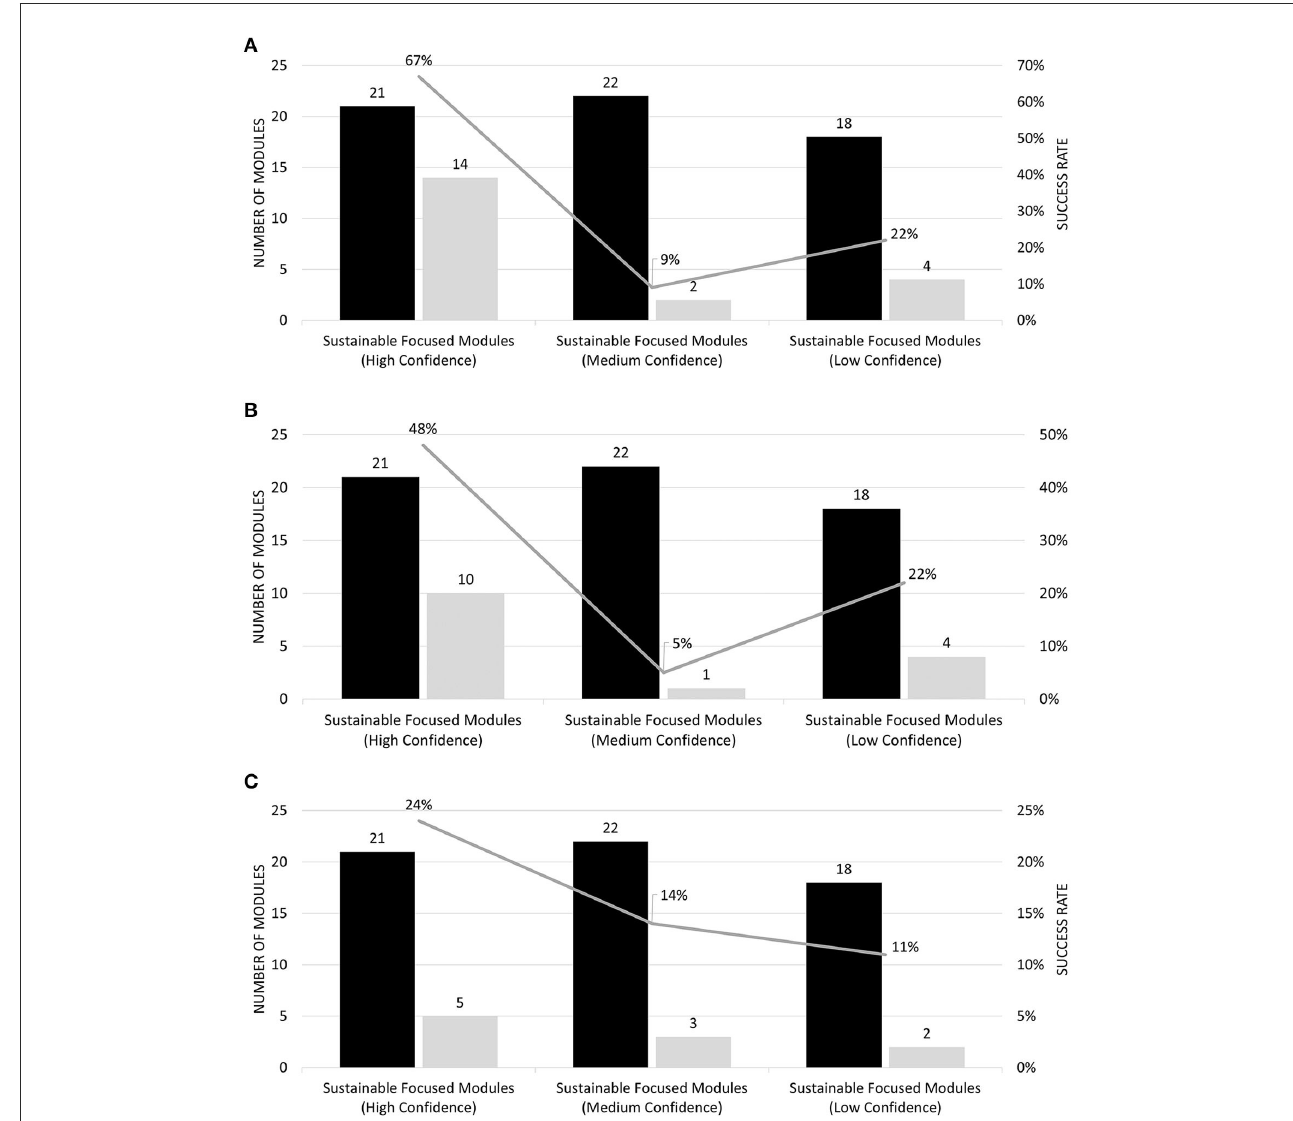
FIGURE2 A comparison of results from each stage of the manual review with those from the computational method based on a search for RK “sustainab” within the “sustainability-focused” category of modules. (A) Stage 1 of manual review process. (B) Stage 2 of manual review process. (C) Stage 3 of manual review